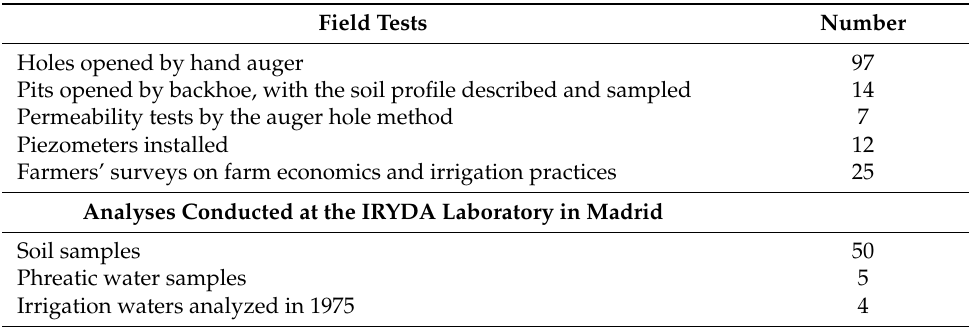
Table 1. Field and laboratory tests in the IRYDA report [1].